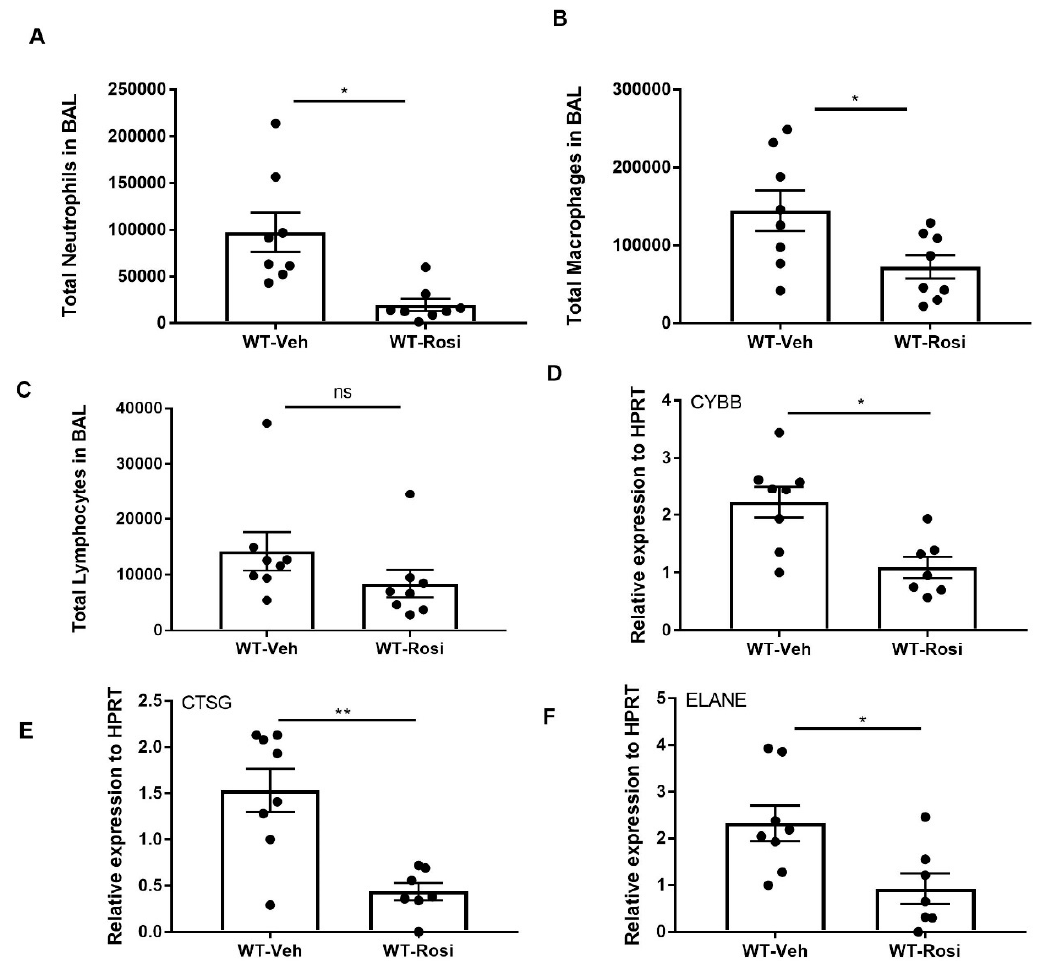
Figure 4. Rosiglitazone treatment decreases the cellular response and genes associated with neutrophil activity during influenza infection. WT male, 6–8 weeks old mice were infected with 100 pfu of influenza ( N = 7–8 per group). Mice were treated with rosiglitazone or vehicle (DMSO) from day 0–6 post-infection and harvested on day 7 post-infection. The BAL cells were stained, and differential cells were counted as described in methods. ( A ) Total number of neutrophils, ( B ) macrophages, ( C ) and lymphocytes were measured in BAL. ( D – F ) CYBB, CTSG and ELANE mRNA expression levels were determined by RT-PCR, N = 7–8 per group, Data are represented as mean ± SEM, * p < 0.05.